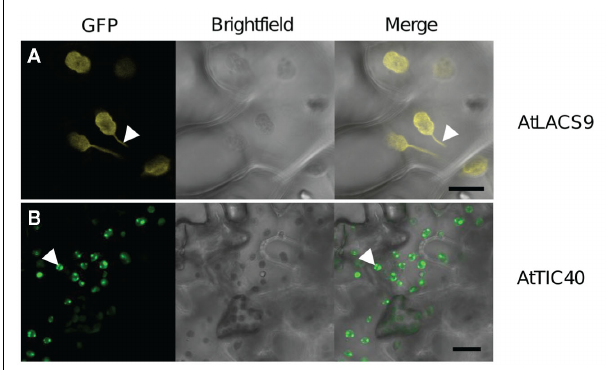
FIGURE 6 | In planta expression pattern of outer and inner envelope proteins. GFP-fusion protein expression patterns in intact leave cells of N. tabacum , 48h after Agrobacterium infiltration. GFP fluorescence (GFP) in yellow, bright-field photo (bright-field) in black/white and an overlay (merge) of representative leave areas are shown. (A) Expression of outer envelope protein AtLACS9–GFP in intact epidermis cells led GFP signal to co-localize with chloroplasts and stromule formation (arrowhead). (B) Expression pattern of the inner envelope protein AtTIC40–GFP shows dot structures associated with the chloroplasts (arrowhead). Also slight GFP rings can be seen around the chloroplasts. Size bars: 20 μ m.